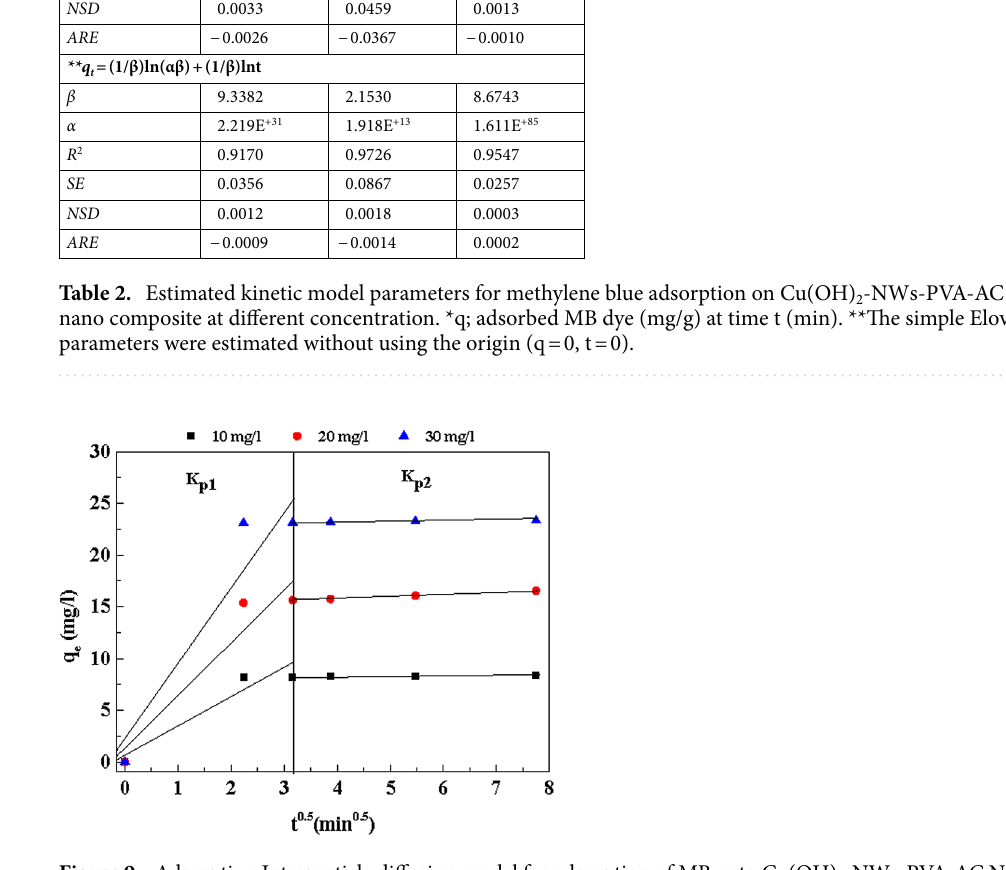
Figure 9. Adsorption Intraparticle diffusion model for adsorption of MB onto Cu(OH) 2 -NWs-PVA-AC Nano- composite. Conditions: As shown in Fig. 7.